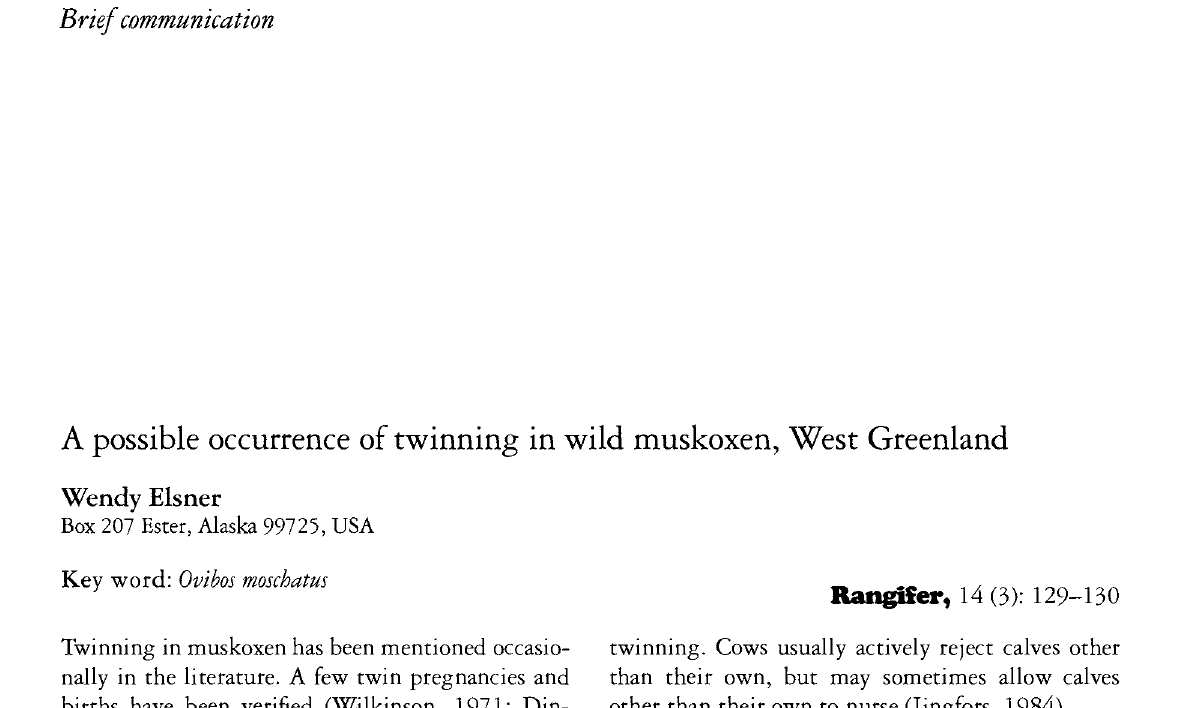
Fig. l . T wo adult female muskoxen each accompanied by two calves photographed near Kangerlussuaq, Greenland, 10 July